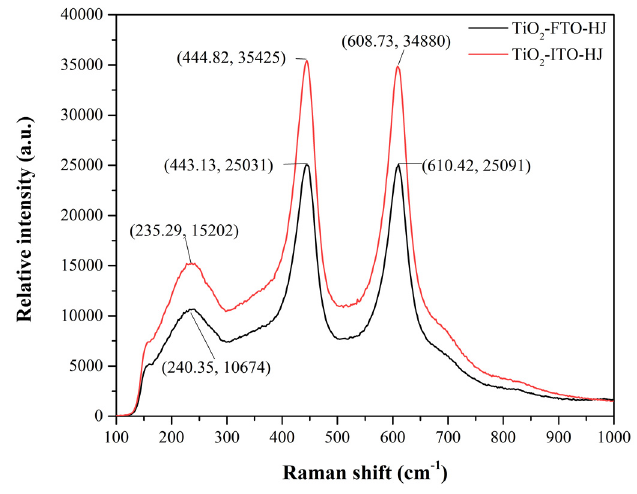
Figure 6. The Raman spectrum of TiO 2 nanoarrays.